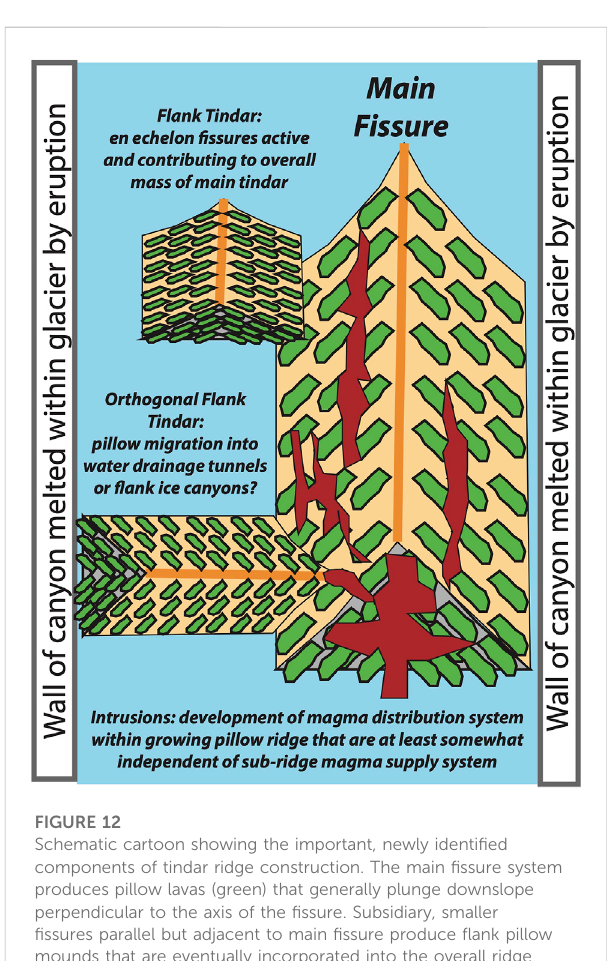
FIGURE 12 Schematic cartoon showing the important, newly identi fi ed components of tindar ridge construction. The main fi ssure system produces pillow lavas (green) that generally plunge downslope perpendicular to the axis of the fi ssure. Subsidiary, smaller fi ssures parallel but adjacent to main fi ssure produce fl ank pillow mounds that are eventually incorporated into the overall ridge structure. Locally fi ssures open orthogonal to the main fi ssure and produce secondary pillow ridges that form perpendicular to the overall fi ssure structure. Intrusions (red) within the ridge system are part of the lava distributary system within the